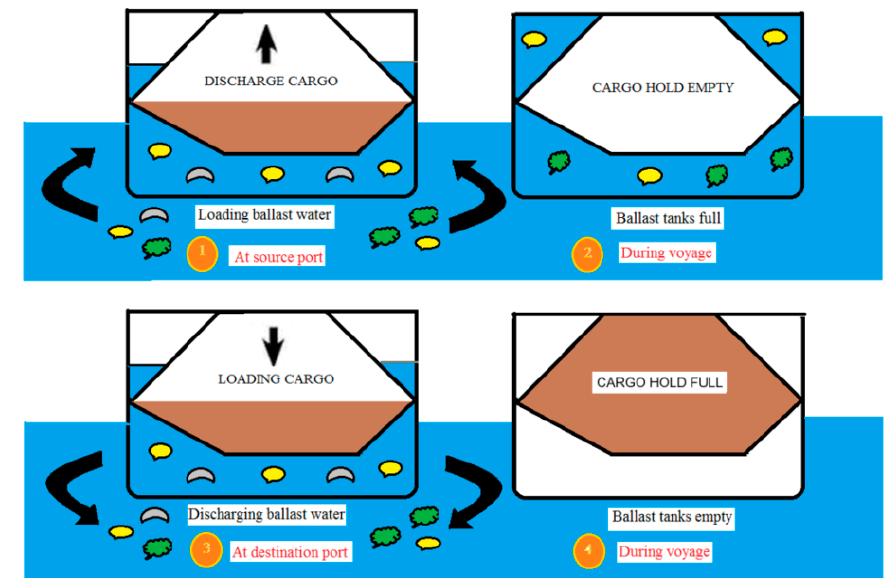
Figure 1. Ballasting/de-ballasting procedures for a bulk carrier.